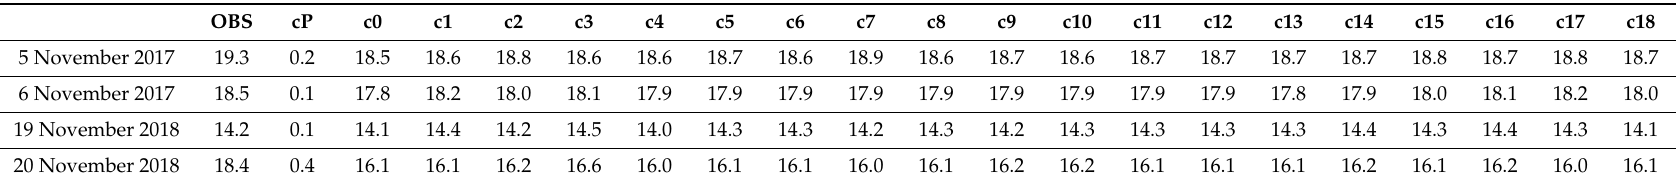
Table 6. Daily maximum T2m values ( ◦ C) averaged over the SCIA stations for the days considered, for observational and model data (all configurations). Maximum deviation (cP) from the reference simulation with the initial condition ensemble.